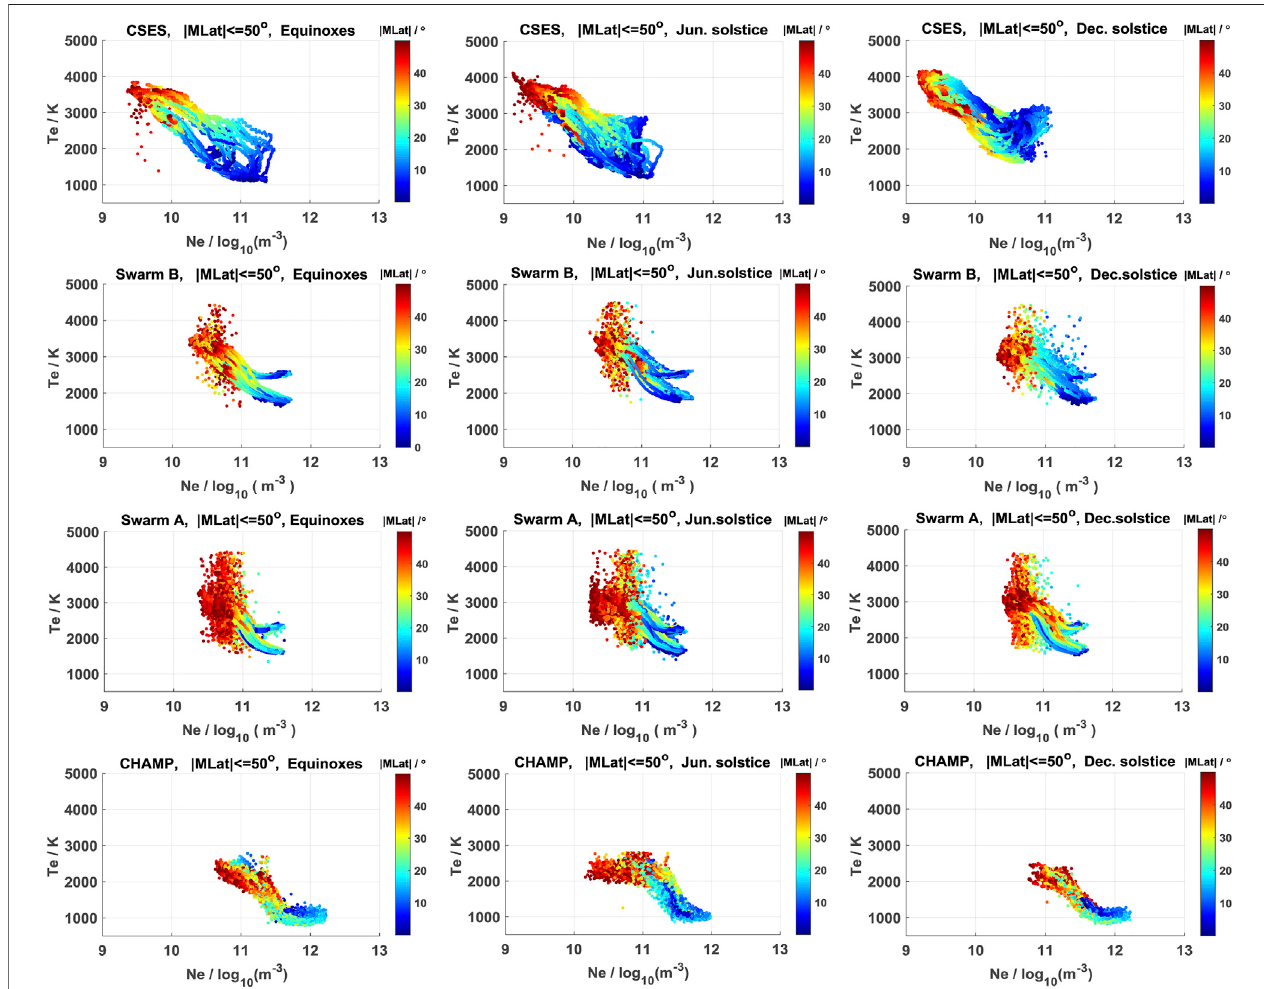
FIGURE 4 | The scatter distributions of Ne and Te around 14:00 LT from CSES, Swarm B, Swarm A and CHAMP are shown from top to bottom. The equinoxes, June solstice, and December solstice are shown in columns from left to right. The colors from blue to red represent the measurements at different MLat range (±50 ° ).